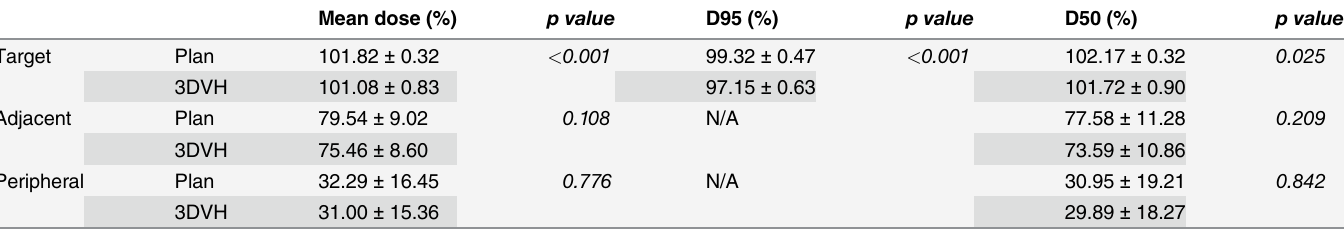
D95: dose covering 95% of the volume; D50: dose covering 50% of the volume; N/A: not assessed. The mean dose is represented as the relative dose compared to the prescribed dose. The statistical signi fi cance of the difference between the planned and predicted dos was calculated by independent t-